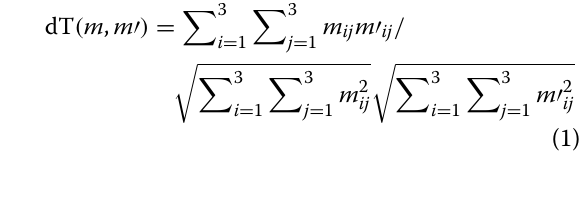
then calculated the differences in the hypocenter loca- tions and focal mechanism solutions for the results deter- mined using manual and automatic picking. Fifty events with various magnitudes were selected from the hypo- center data, followed by a comparison. Figure 3 shows the differences in the locations and tensors calculated from focal mechanisms with magnitudes of 0.5 to 3.2. − We only used the auto-picked hypocenter results that had an RMS residual of less than 0.15 s and focal mecha- nisms with A and B HASH ranks. The colors plotted in Fig. 3 are classified by the focal mechanism HASH rank using the manually picked data (reference data). For ref- erence focal mechanisms with A and B ranks, the hori- zontal differences in the hypocenters are less than 0.4 km for magnitudes greater than 0. The vertical differences in location are less than 1 km. The reliability of the focal mechanism was evaluated by calculating the tensor dot product (DTensor, dT ) of the automatic and manual solutions. The tensor dot product between two order ten-